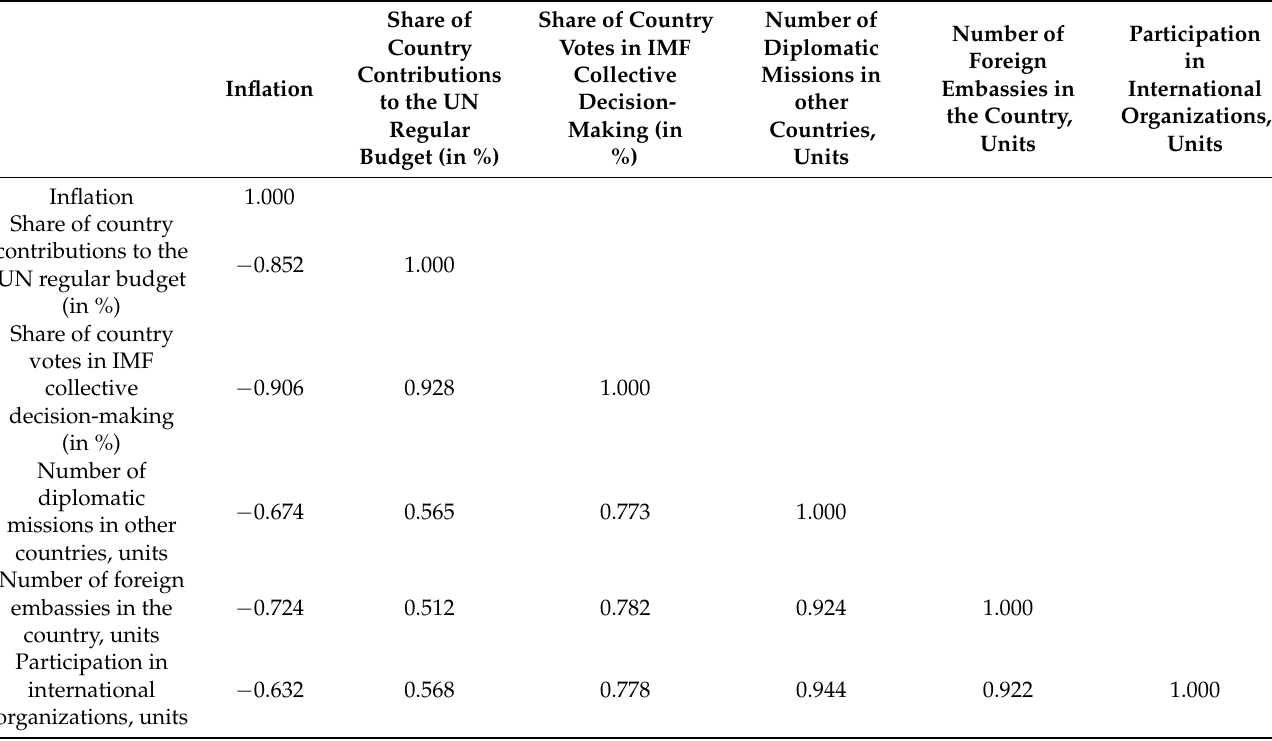
Table 11. Results of correlation analysis of inflation and factors of political